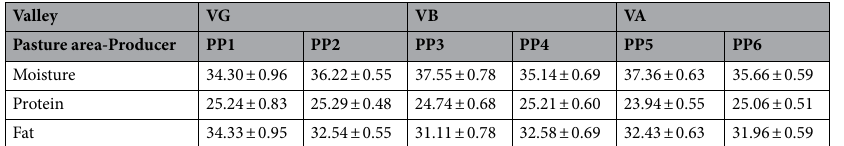
Table 1. Proximate analysis mean values by Valley and Pasture area/Producer in % (g/100 g wb). VG Gerola valley, VB Brembana valley, VA Bitto di Albaredo valleys. Data expressed as LSM ±